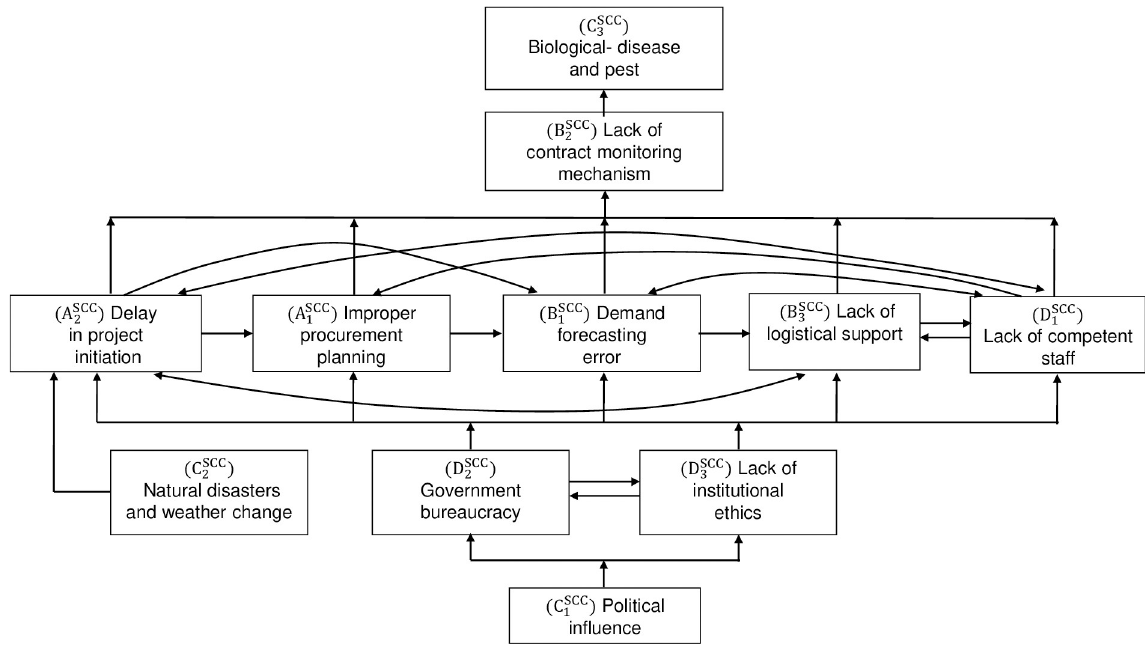
Fig 5. The ISM model of SCCs in public sector agriculture